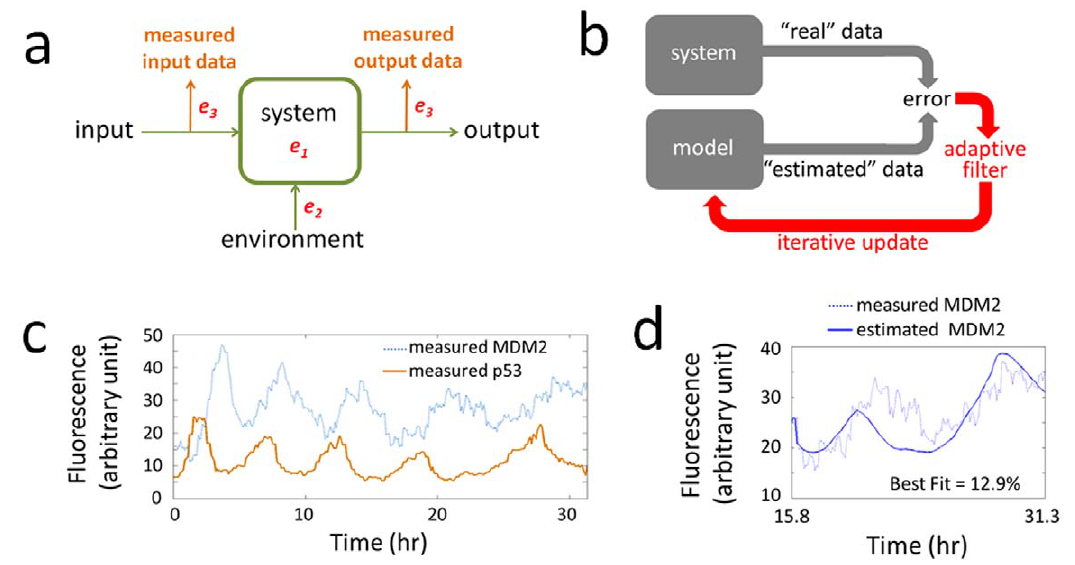
Figure 1. System identification of the p53-MDM2 gene network. ( a ) Models describe relationships between measured input and output data. They are subject to three types of uncertainty: system uncertainty ( e 1 ), environmental uncertainty ( e 2 ), and measurement uncertainty ( e 3 ). ( b ) An adaptive filter iteratively adjusts the model parameters based on the error between the measured and estimated data. ( c ) p53 and MDM2 levels oscillate after radiation-induced DNA damage. ( d ) The best time-invariant ARX model ( n a =1, n b =3, n k =2) only has a Best Fit score of 12.9%.